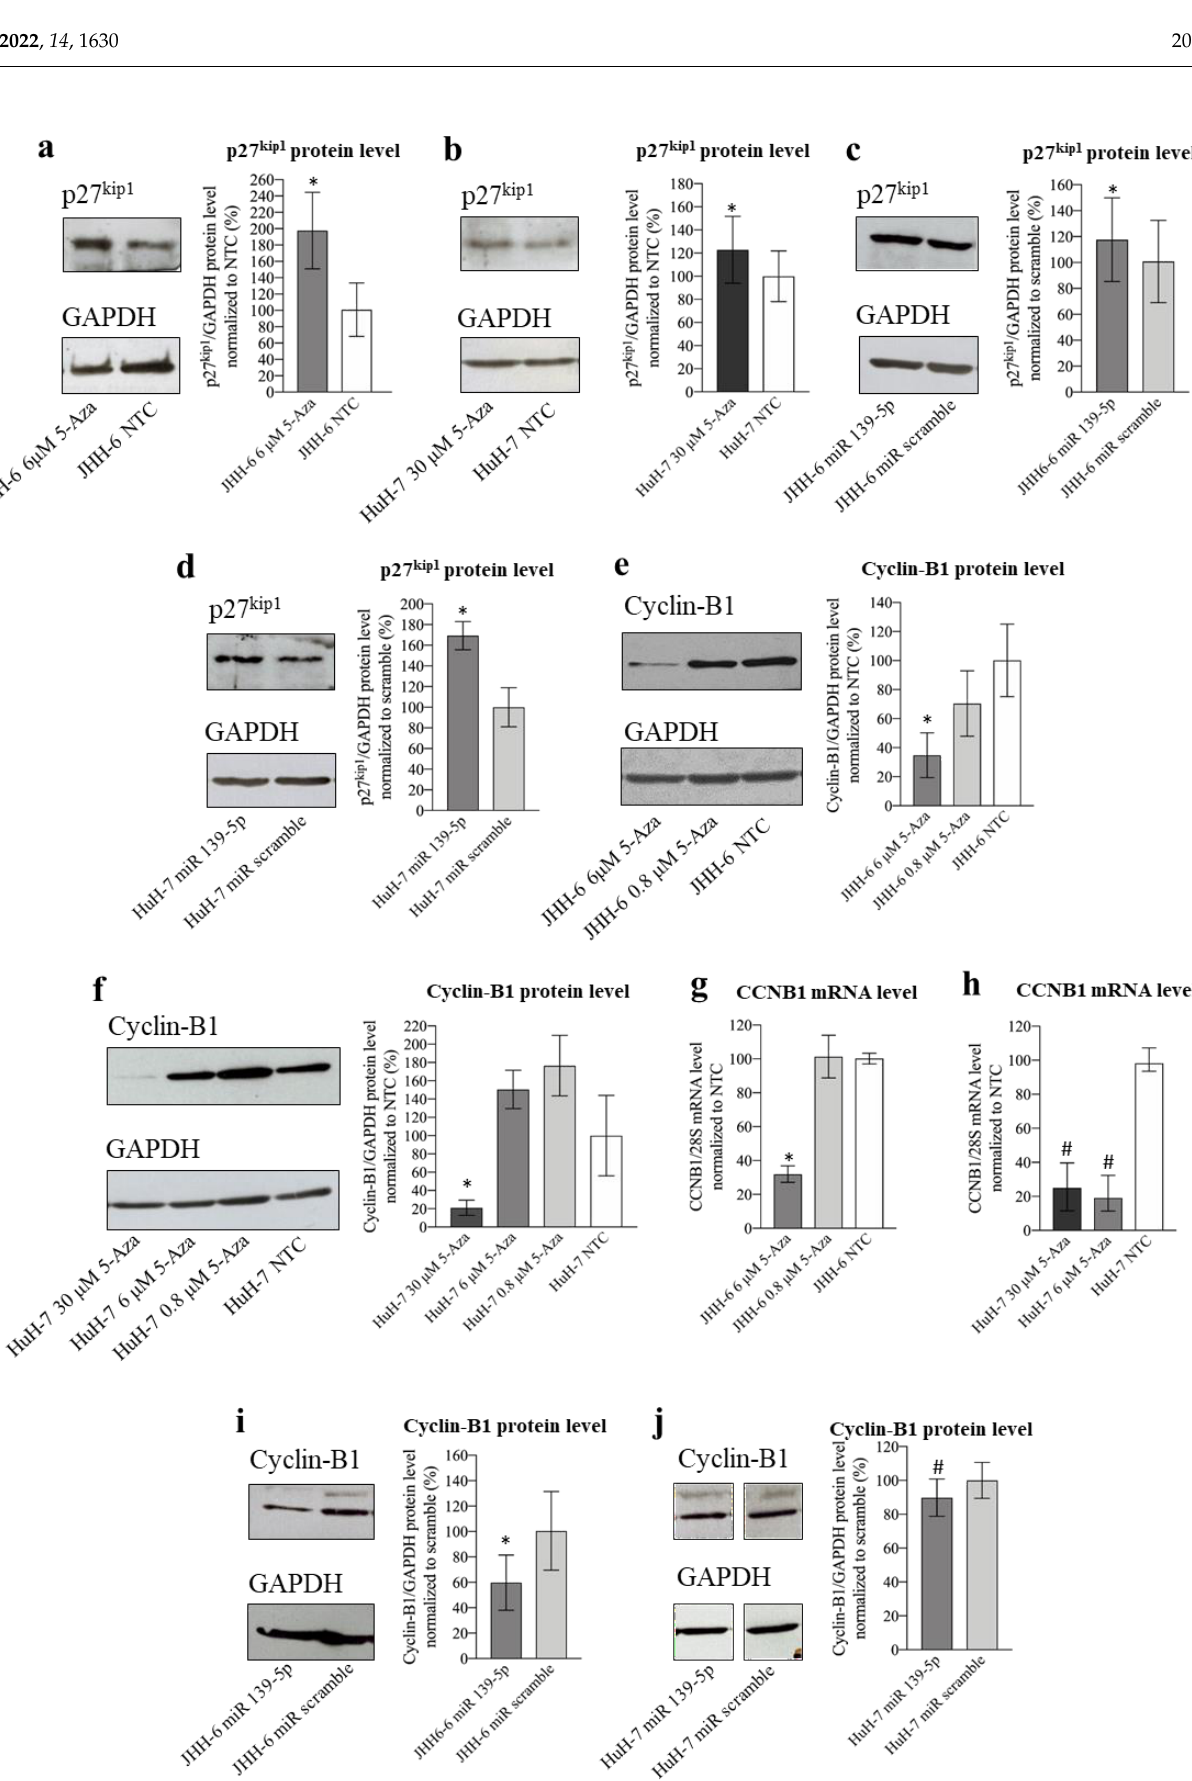
Figure 7. Effects of 5-Aza and miR-139-5p on p27 kip and cyclin B1 expression. ( a ) Effects of 5-Aza on p27 kip1 protein level in JHH-6. Left, representative Western blot (GAPDH was introduced